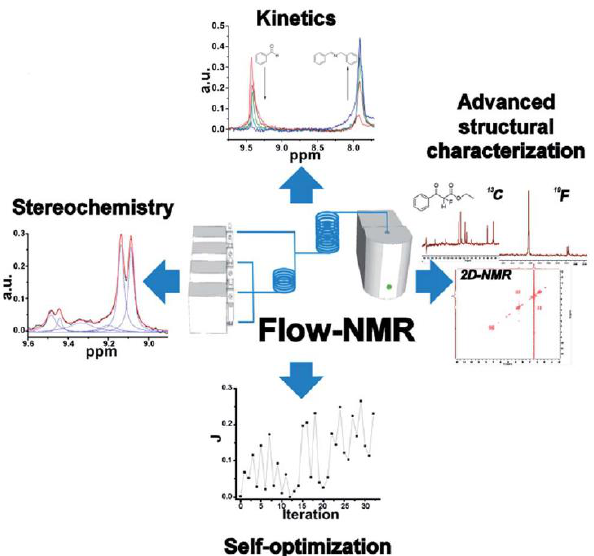
Figure 12. Schematic application of benchtop NMR spectroscopy for process monitoring. Adapted with permission from [74], Royal Society of Chemistry, 2015.